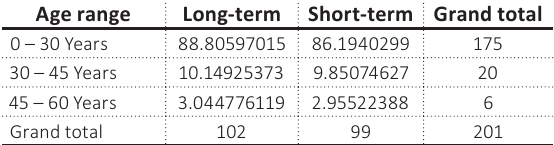
Table 2. Expected frequencies of impact of